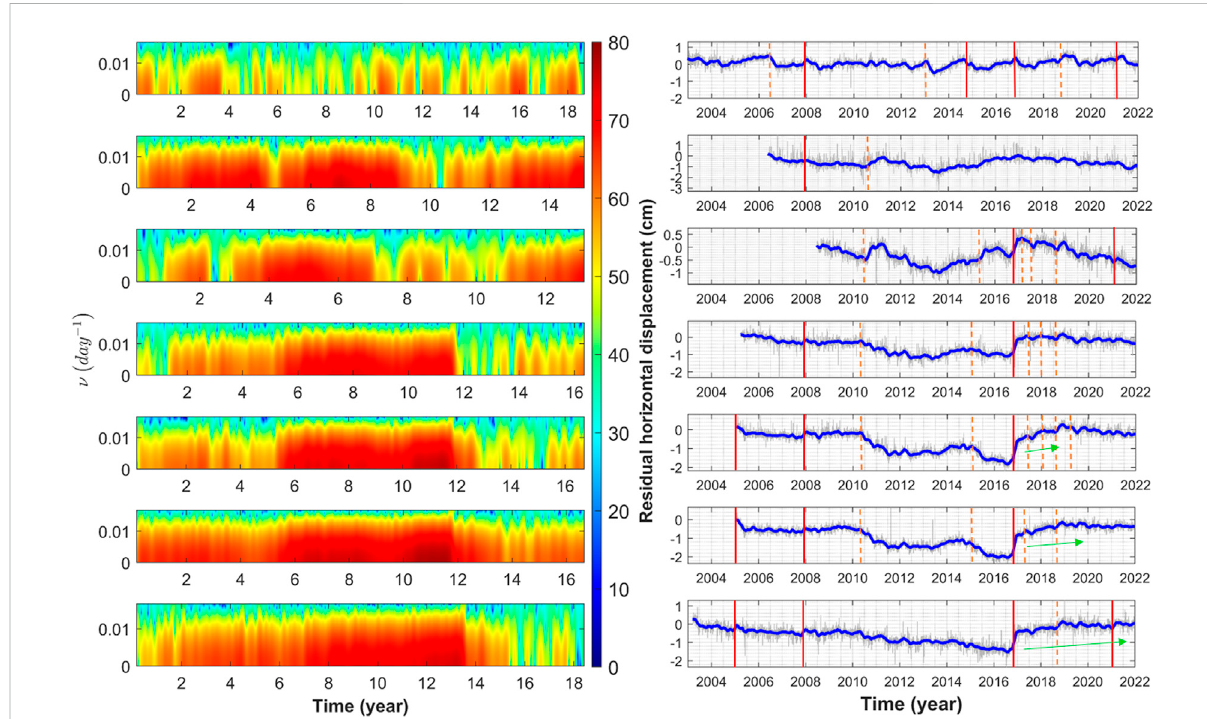
FIGURE 9 Spectrograms and residual horizontal geodetic time series of seven GNSS stations in Manawatu. From top to bottom: HAST, KERE, BSHT, VGMO, VGMT, VGPK, and NYPT. SSEs are observed, moreover, the spectral amplitudes are noticed to increase before the Kaikoura Earthquake (13/ 11/2016, M w 7.8) downline of the Manawatu ETS zone in the recordings of NYPT, VGPK, and VGMT. The red lines stand for large earthquakes which caused a measurable displacement of the GNSS stations, while the orange dashed lines represent slow slip events. The green arrows highlight afterslip. Modi fi ed from Zaccagnino and Doglioni